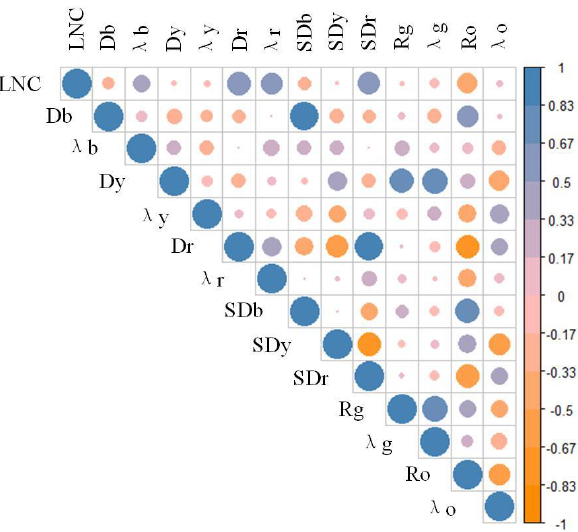
Figure 7. Matrix diagram of the correlation coefficient between band positions and LNC in wheat. Table 3. The estimated results for wheat LNC based on different